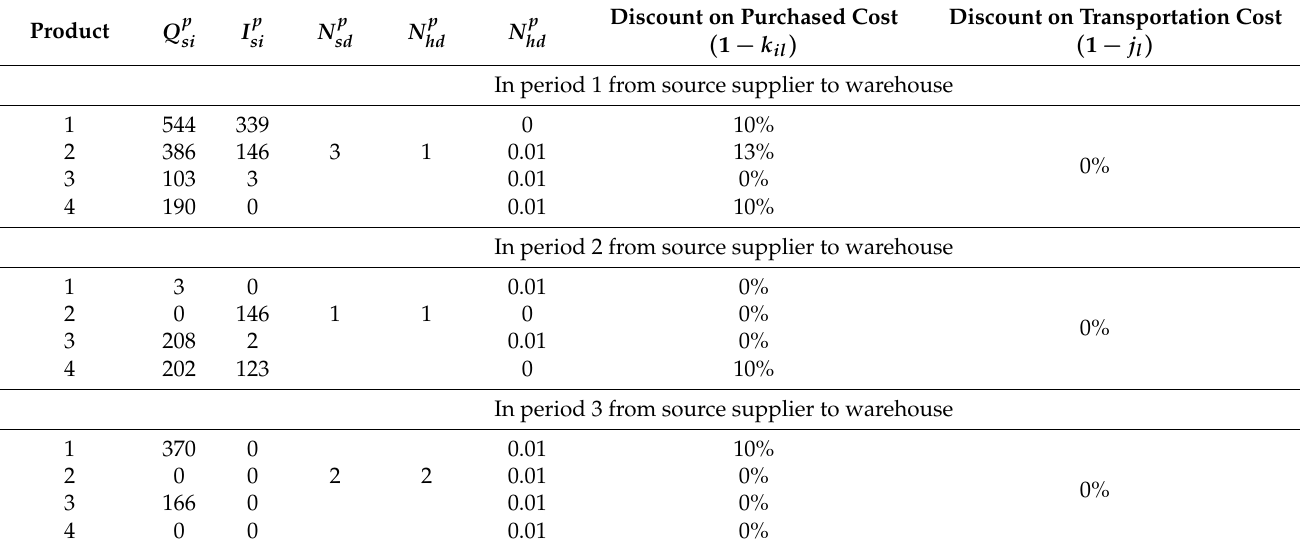
Table A12. Solution of our proposed model from supplier to warehouse.